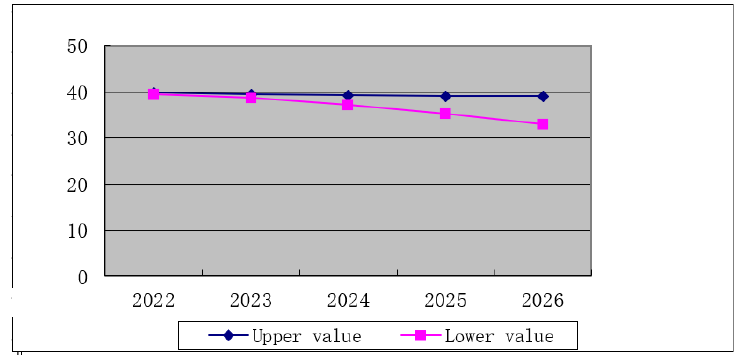
Figure 3. The variation interval of water requirement with the influence of secondary industry in Beijing.